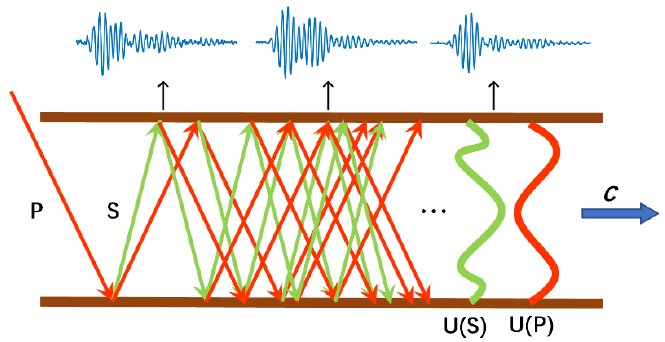
Figure 1. Formation of Lamb waves in planar waveguide.